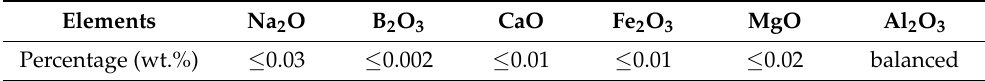
Table 1. Composition of Al 2 O 3 powder.